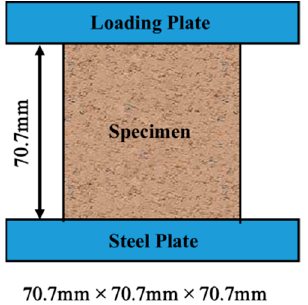
Figure 3. Schematic diagram of compressive strength test.